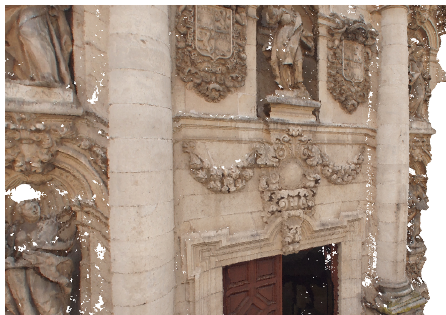
Figure 1: Partial reconstruction of the Baroque facade of the Uni- versity of Valladolid with Micmac extension